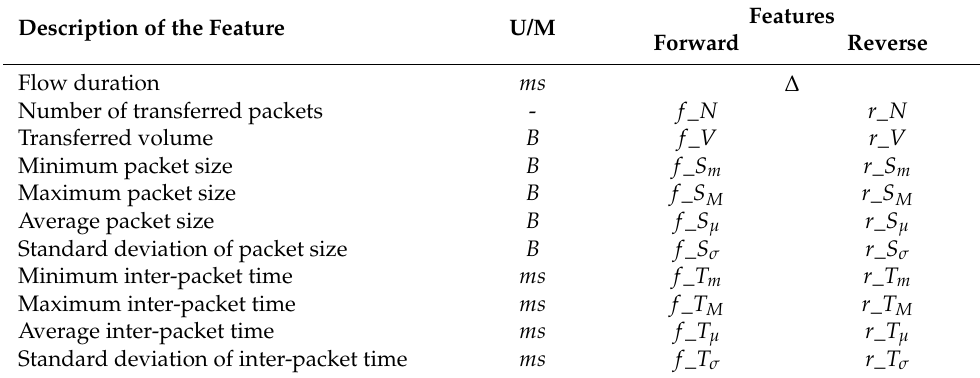
Table 3. Statistical